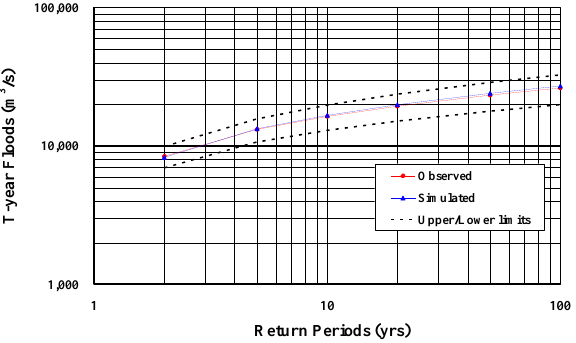
Figure 7. Observed and Simulated T-year Floods at the Paldang Dam (Daily).